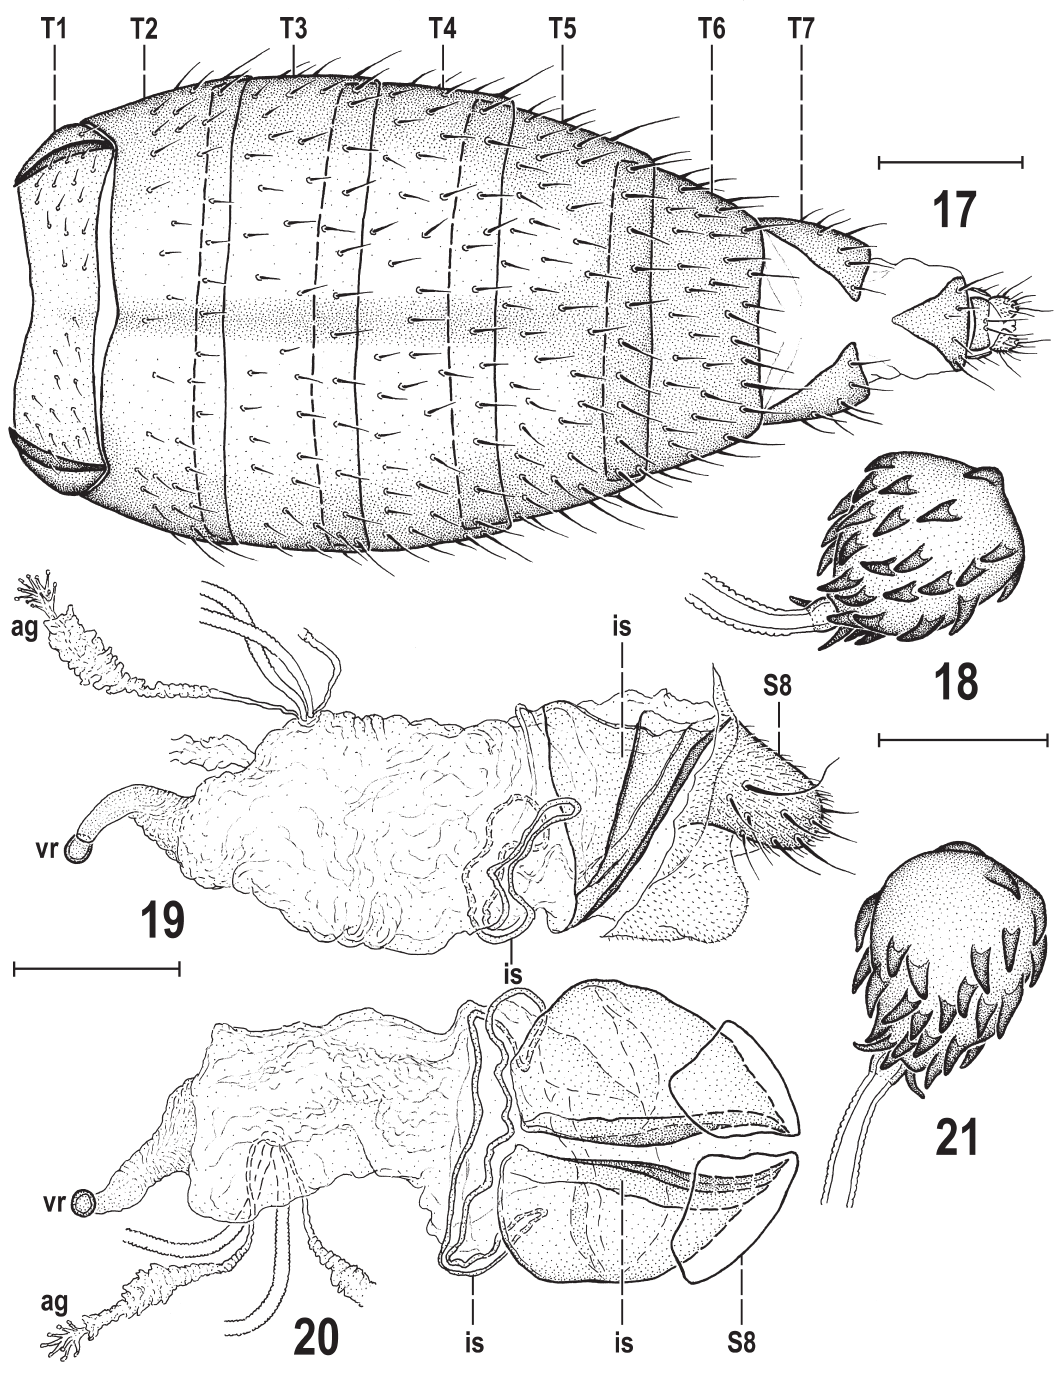
Figs 17–21. Mumetopia interfeles Roháček sp. nov., female paratypes (SMOC MIT080–MIT083). 17 . Abdomen, dorsal view. 18 , 21 . Spermatheca. 19 . Genital chamber and S8, lateral view. 20 . Same, ventral view (setosity of S8 omitted). Scale bars: 17 = 0.2 mm; 18, 21= 0.05 mm; 19–20 = 0.1 mm. For abbreviations see Material and